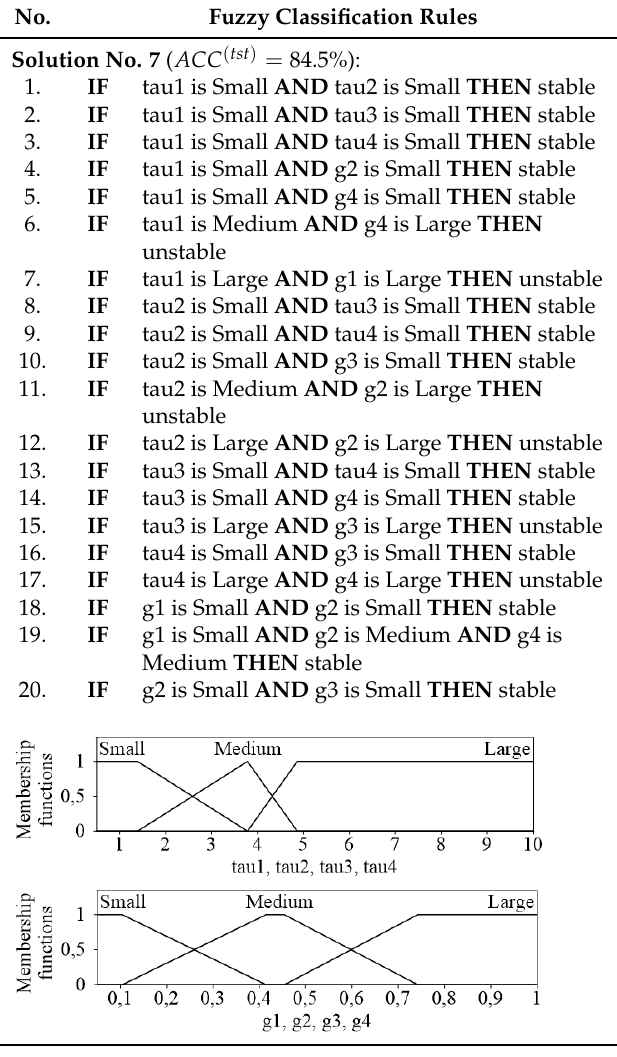
Table 4. Fuzzy rule base for SPEA3-based solution (FRBC) 7 from Figure 4 which is characterized by the highest test-data